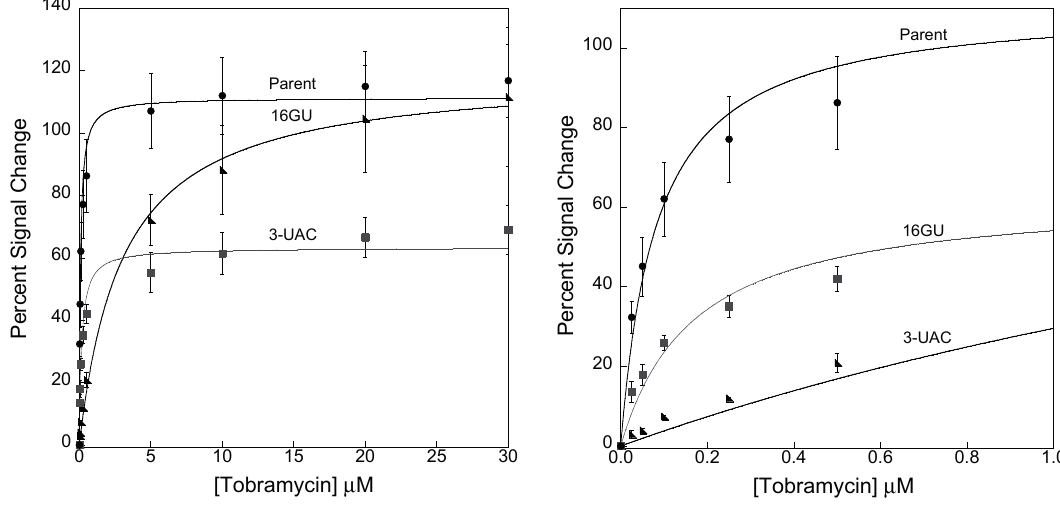
Figure 7. ( Left ) A comparison of the sensor responses when employing the parent, 16GU, and 3-UAC aptamers. The grey box is representing the therapeutic window of tobramycin from ~7–18 µM; ( Right ) A zoom in of the 0–1 µM window to show the difference in sensor function for the parent, 16GU and 3-UAC aptamer sequences. These data represent titration curves calculated as percentage signal change using voltammetric peak currents as described in the experimental section. Each data point represents the average and standard deviation of at least three independently fabricated